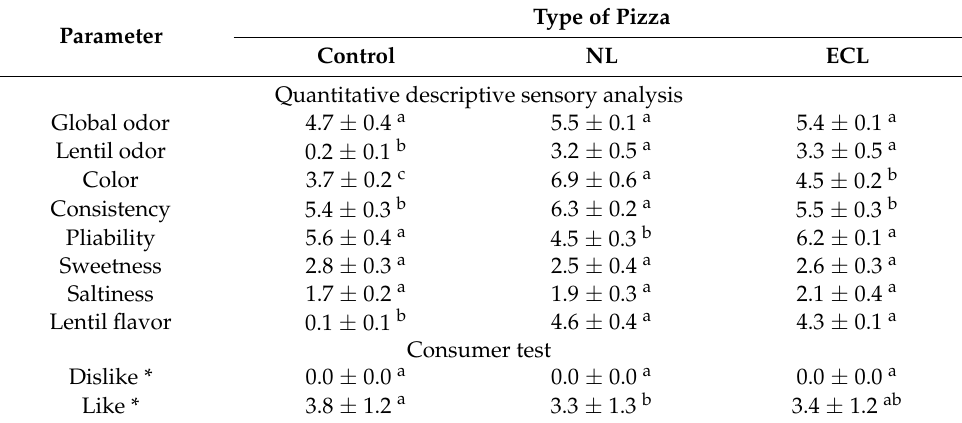
Table 8. Sensory scores recorded by quantitative descriptive sensory analysis and by consumer test carried out on the experimental GF pizza samples. NL pizza = pizza crust enriched with native lentil flour; ECL pizza = pizza crust enriched with extruded-cooked lentil flour. The range of the scale was 0–9 contractual units (c.u.) for the quantitative descriptive sensory analysis and 1–5 c.u. for the consumer